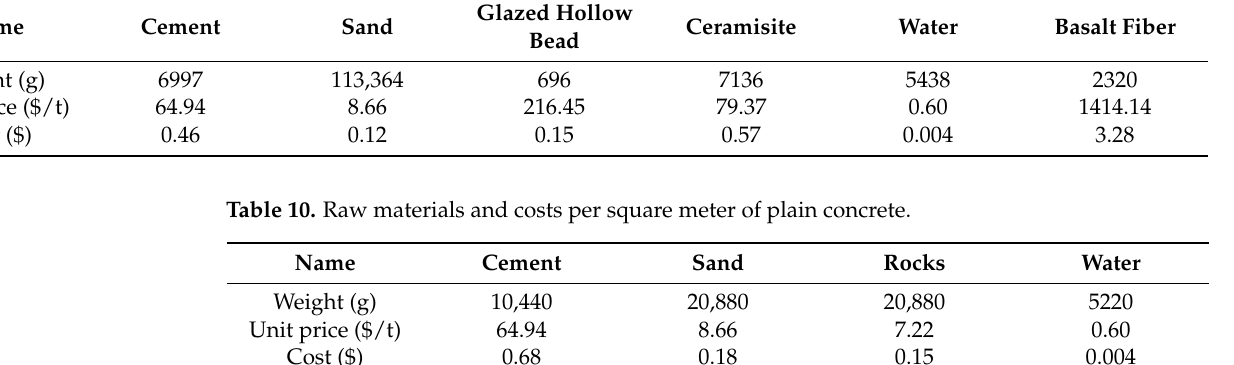
Figure 20. Wind-flow temperature field at the exit of the roadway: ( a ) Wind flow temperature field at the exit of the roadway under plain concrete support; ( b ) Wind flow temperature field at the exit of the roadway under insulated concrete support.